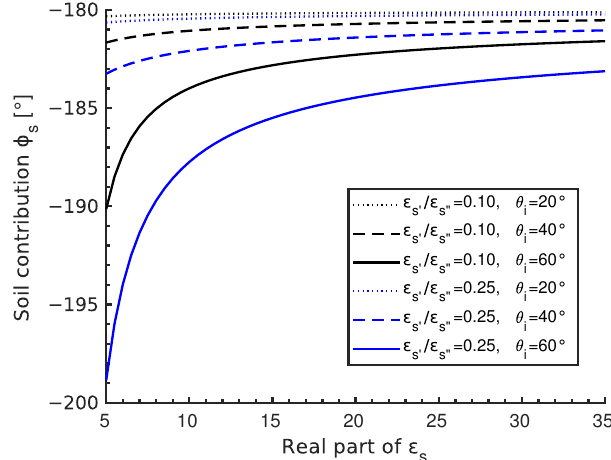
Figure 1. Sensitivity of soil term on the real part of the dielectric constant. The imaginary part is assumed to be 0.10 (black lines) and 0.25 (blue lines) of the real part.